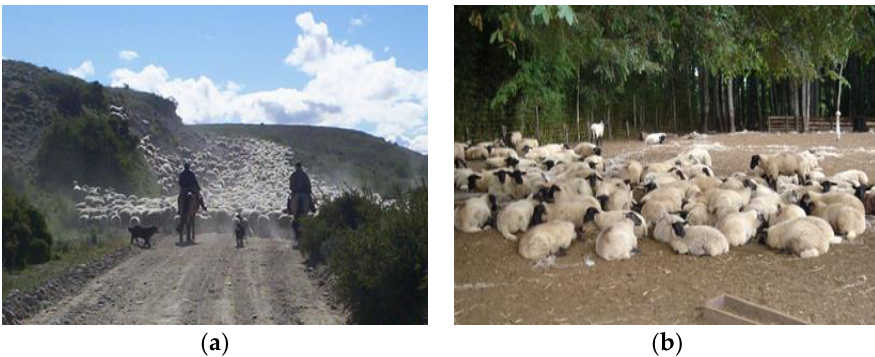
Figure 1. ( a ) Rounding up and driving sheep in the Chilean Patagonia; ( b ) lambs resting in a pen before loading in small farmer conditions of central-southern Chile.